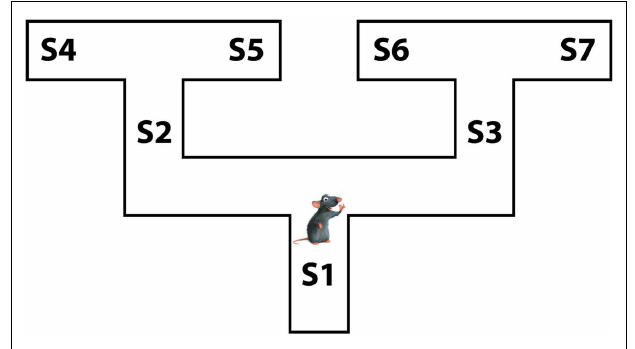
FIGURE 1 |The rat navigation scenario used in the simulations: a